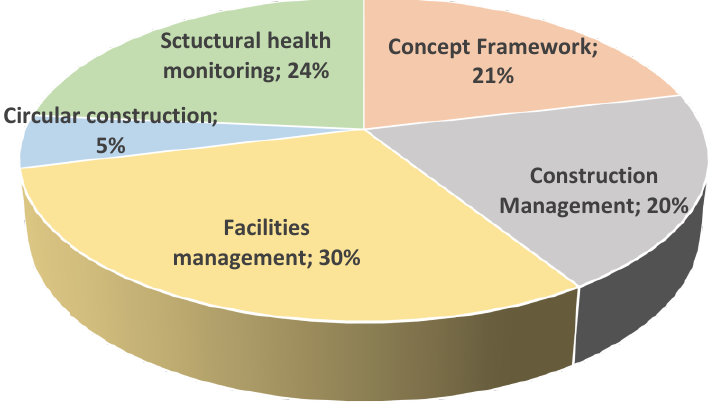
Figure 2. Distribution of the DT studies within AEC research fields.